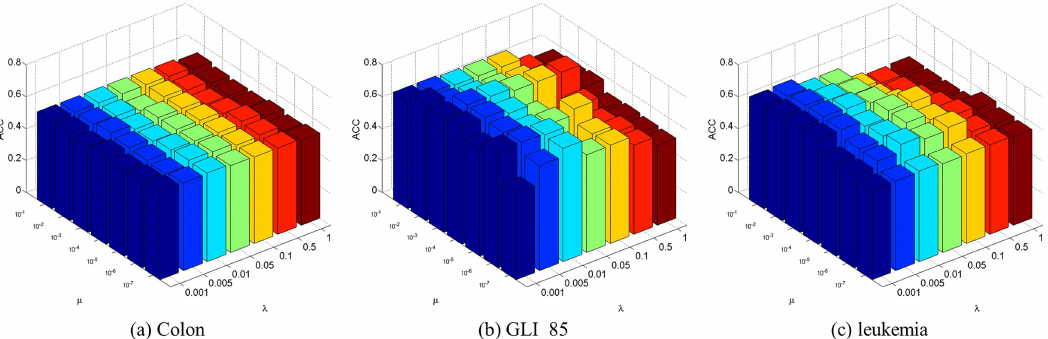
Figure 1. Influence of parameters on clustering